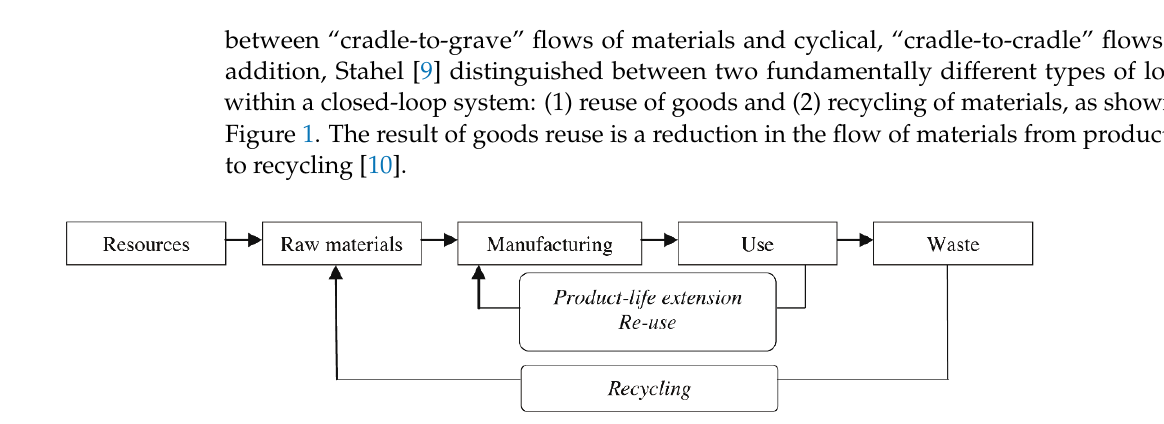
Figure 1. Different types of loops within a closed-loop system [11].